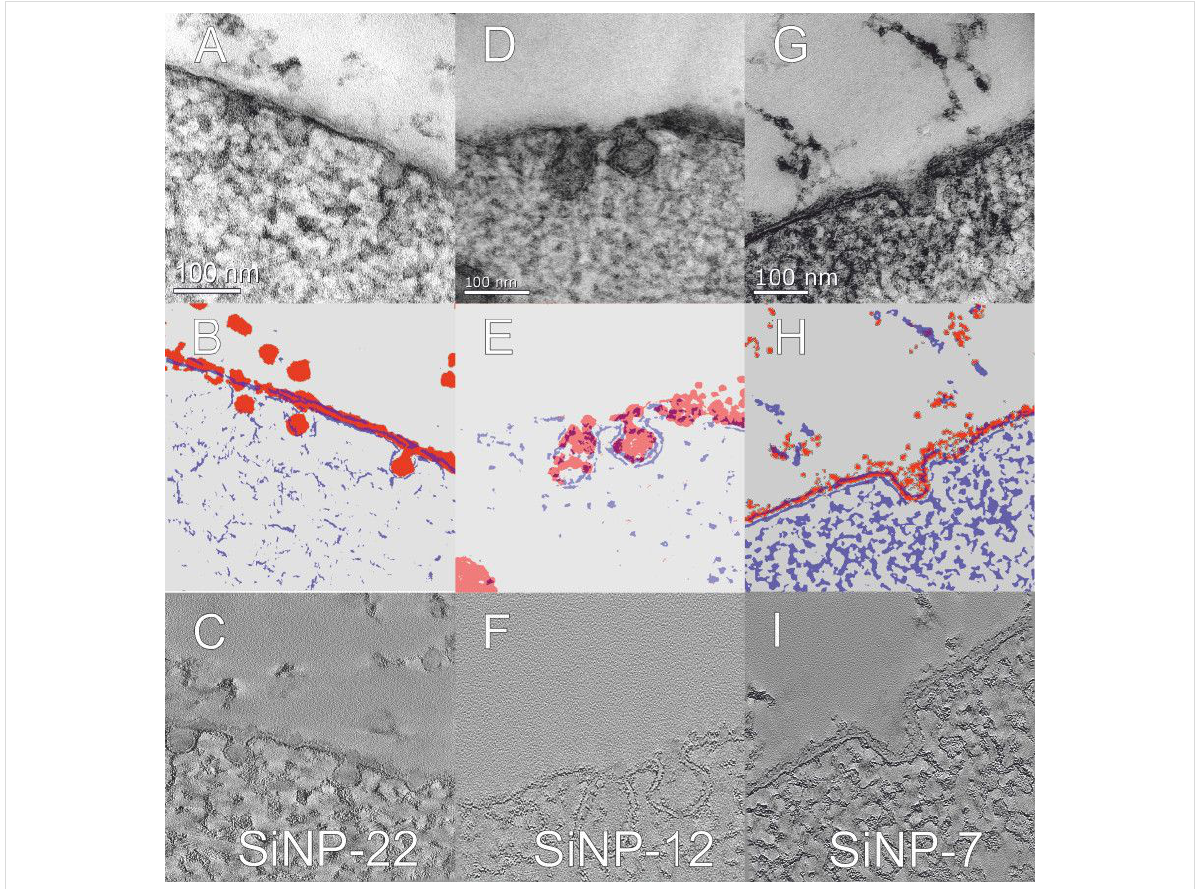
Figure 11: TEM brightfield micrographs of high-pressure frozen hMSC cells exposed to SiNPs at a concentration of c = 75 µg·mL − 1 for 10 min, stained with OsO 4 and uranyl acetate (micrographs A, D and G show SiNP-22, SiNP-12 and SiNP-7, respectively). Prior and during the incubation, the hMSCs were kept at 4 °C. For clarification purposes the illustrations below (B, E and H) represent the membrane (blue) and the SiNPs (red) as extracted from energy filtered TEM measurements of the above micrographs. Finally, the micrographs in the bottom row show an optical slice from the respective tomography reconstruction (C, F and